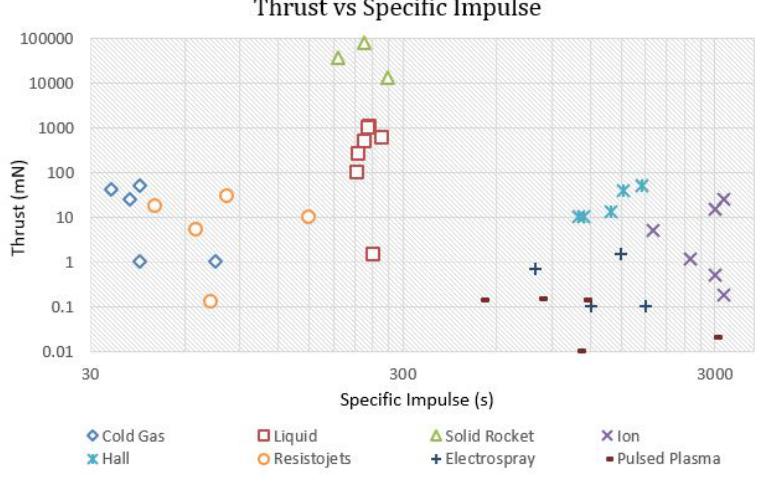
Figure 9. Thrust vs. Specific Impulse for Propulsion Systems from